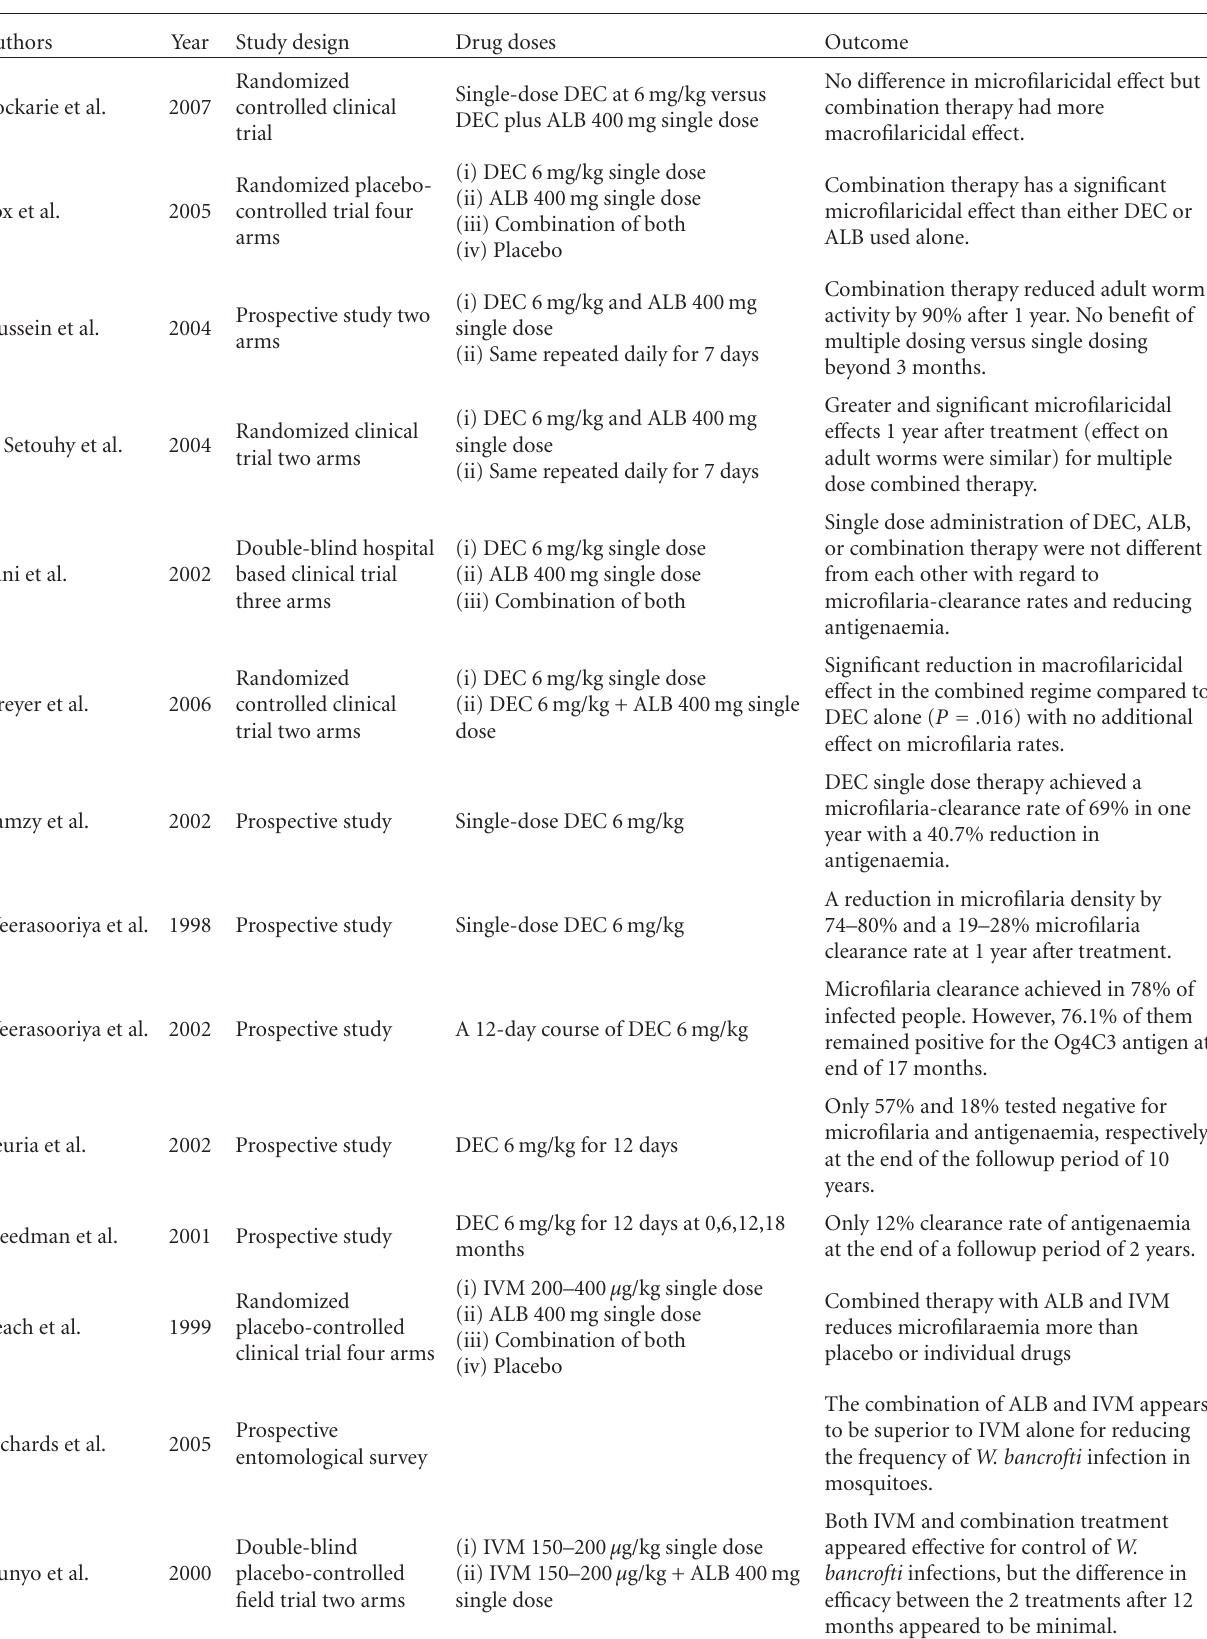
Table 1: Summary of clinical trials on drug treatment quoted in